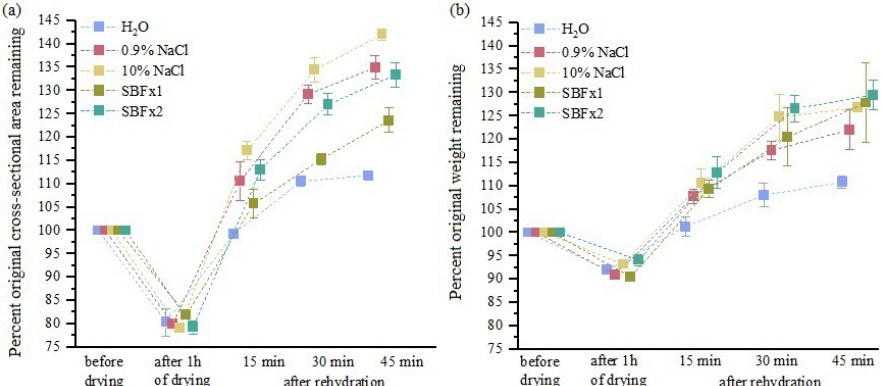
Figure 7. Changes in ( a ) cross-sectional area and ( b ) the weight of fascicle bundles during 60 min of drying followed by rehydration (mean ± standard deviation). Values are given in percentage relative to the initial area measurement and weight immediately after excision. (before drying); n = 10.